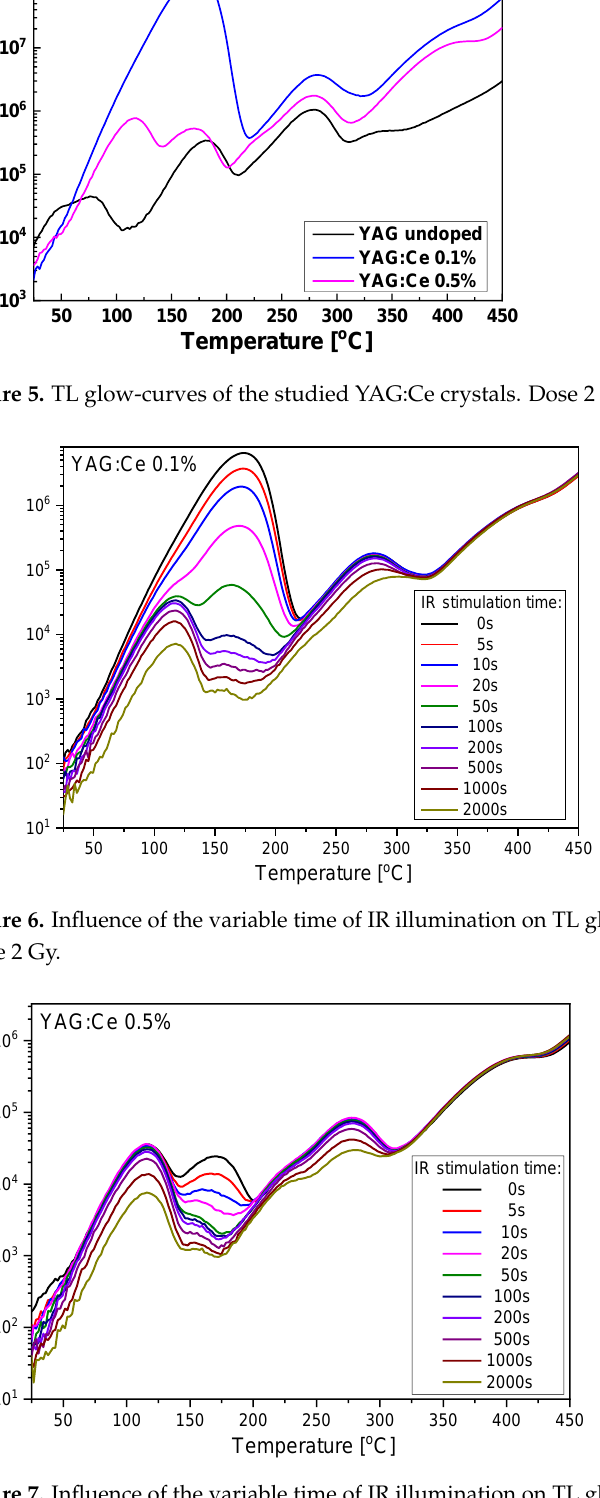
Figure 8. Influence of the variable time of IR illumination on TL glow-curves of undoped YAG crys- tal. Dose 2 Gy. More in-depth analysis of the TL glow-curves was performed by their deconvolution into separate peaks (assuming peak shapes according to the first-order kinetic model). Figures 9 – 11 compare deconvoluted glow-curves of YAG:Ce crystals after 2000 s IR stim- ulation, with those not illuminated by IR. It is worth noting, that reduction of the domi- nant peaks by IR leads to revealing of other peaks, previously unnoticeable. Four peaks seem to be present invariably in all YAG:Ce samples: P1 (located in the range 110 – 119 °C, depending on a sample and a particular measurement), P3 (167 – 180 °C), P5 (275 – 285 °C) and P6 (400 – 405 °C). As they are present also in the undoped YAG crystal, it seems that they are related to intrinsic defects or/and some unwanted impurities. Figure 12 summarized changes in the fitted amplitude of the main peaks following different times of IR stimulation. It is apparent, that most of the IRSL signal is related to the peaks P2 and P3, which show a steep decrease with the stimulation time. P2 is absent in the undoped YAG, which suggests that it is related to Ce-doping (the peak marked as